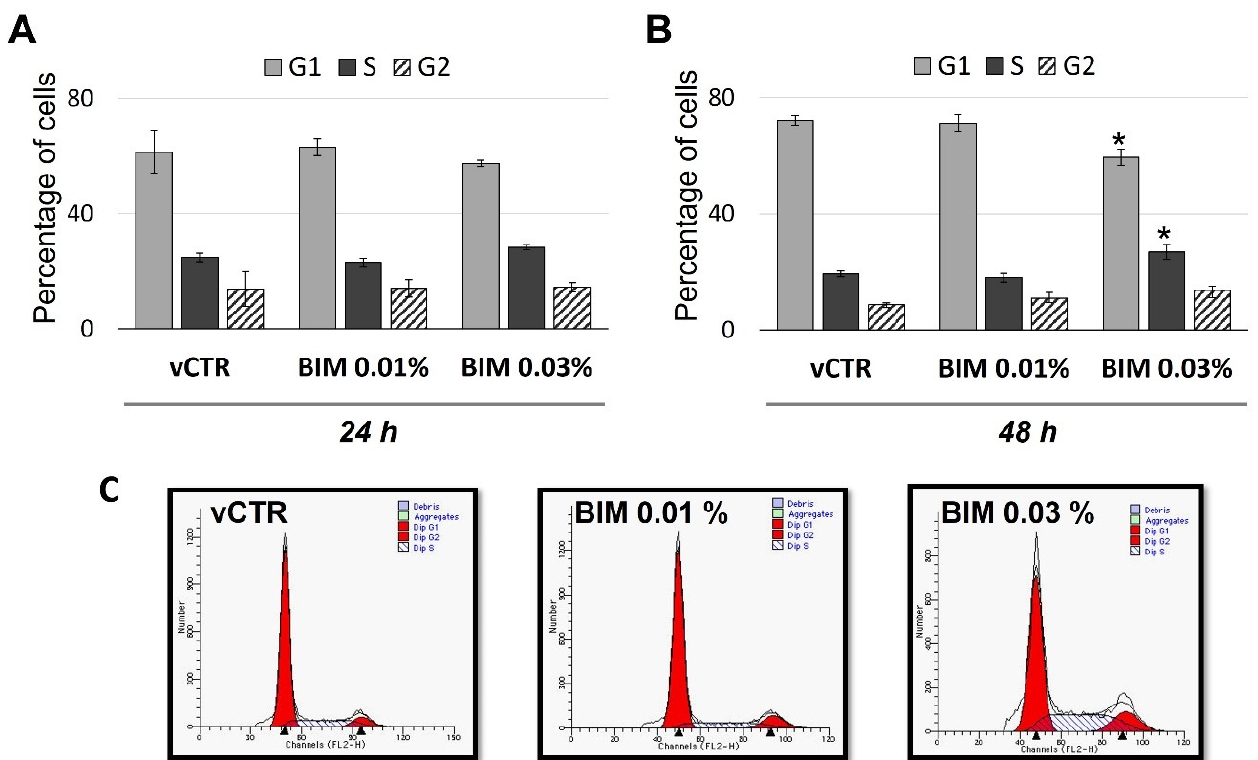
Figure 2. BIM 0.03% induces S/G2 arrest in HCE cells. Long-term exposure analyses of cell cycle phases distribution (percentage of cells) in HCE cells incubated in the absence (vCTR) or the presence of BIM 0.01% and 0.03% for 24 ( A ) and 48 h ( B ); BIM 0.03% induces a significant increment in the percentage of cells in S phase, followed by a slight increase in G2 phase, at 48 h of exposure; on the contrary, no effects for BIM 0.01% are detected. ( C ) Representative FACS profiles of cell cycle phases analyses at 48 h treatment. Values from three independent experiments are expressed as the media ± SE; one-way ANOVA (Dunnett’s method); * p < 0.05 compared with vCTR.